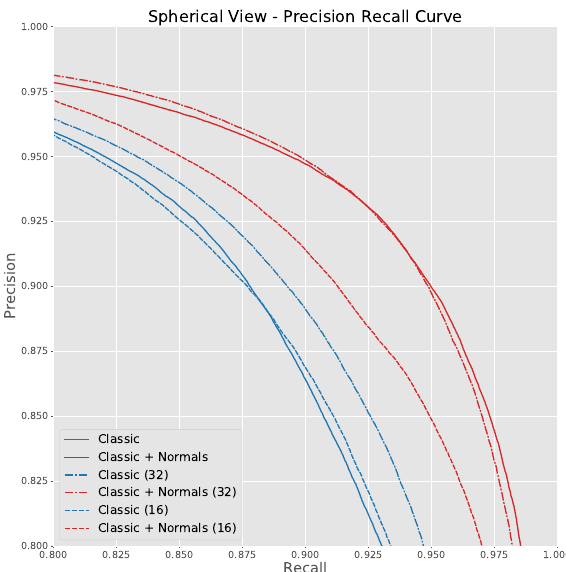
Figure 9. KITTI Road Segmentation with SV images: Precision-Recall Curve for various features with and without sub-sampling.